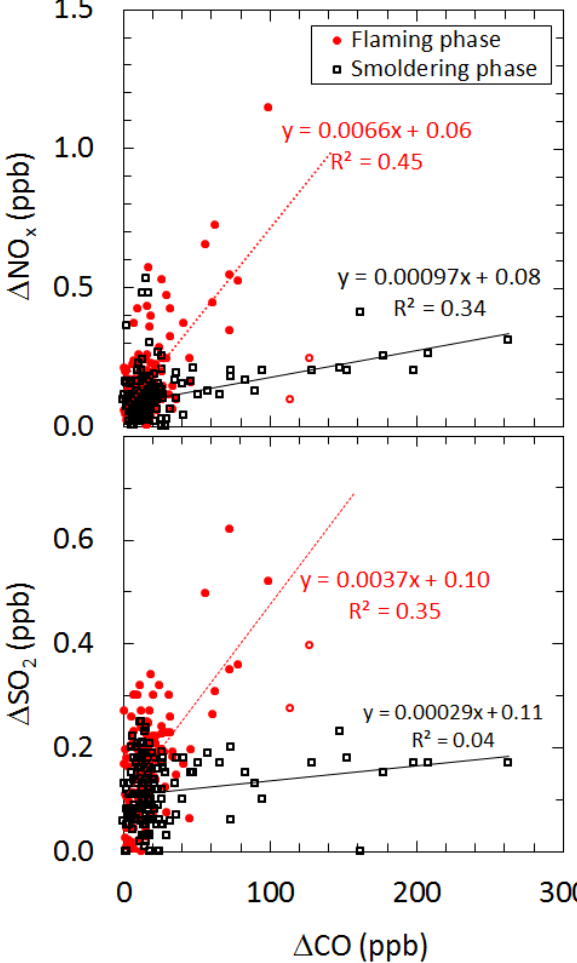
Fig. 6. Excess NO x and excess SO 2 concentrations as a function of excess CO concentration at the SMEAR II mast during the flaming and smoldering